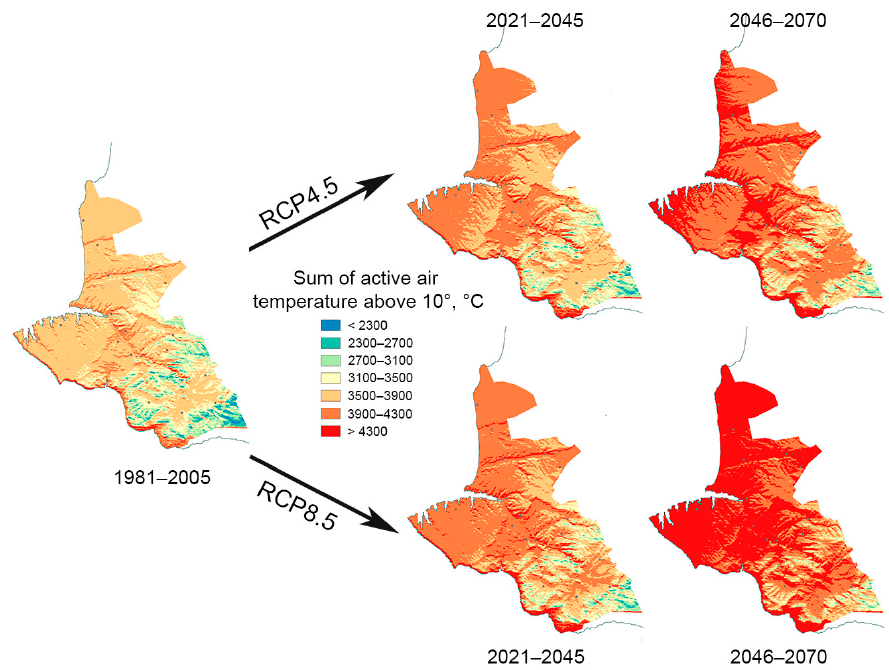
Figure 3. Spatial distribution of the sum of active temperatures above 10 °C over the Sevastopol region obtained by the ensemble of RCMs for the base (1981–2005) and two future periods (2021–2045 and 2046–2070). Table 2. Distribution of the area (%) of the sum of active temperatures above 10 °C for future periods under various RCP. Sum of Effective Temperature ( ◦